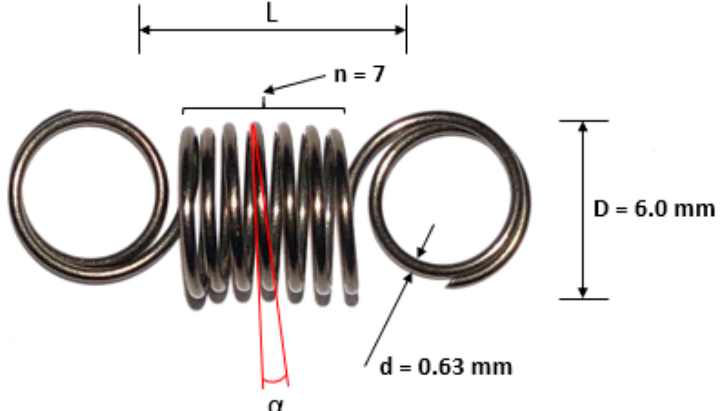
Figure 1. The geometrical design of a NiTi coil spring, thickness (d), outer diameter (D), length (L), number of active coils (n), and initial pitch angle ( α ).